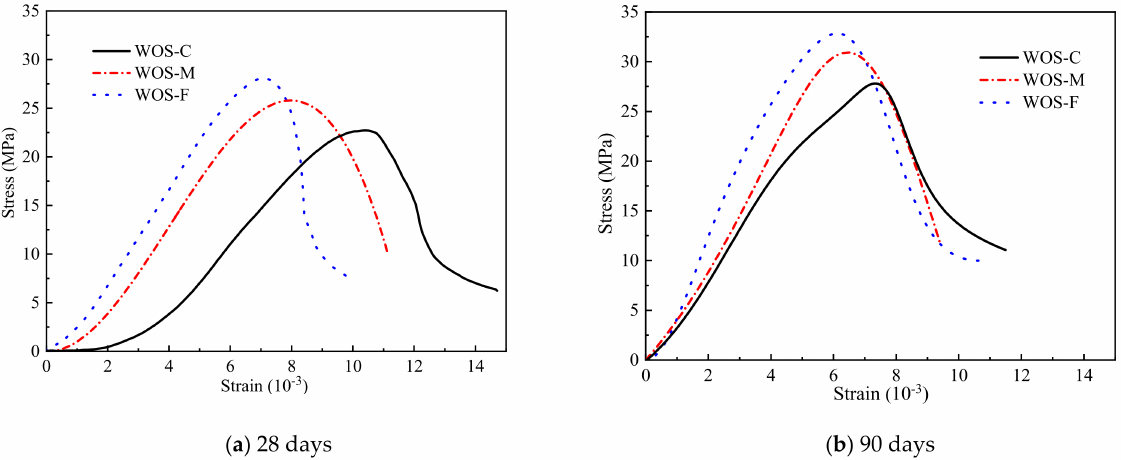
Figure 12. The effect of the particle size on the stress–strain. ( a ) 28 days. ( b ) 90 days.